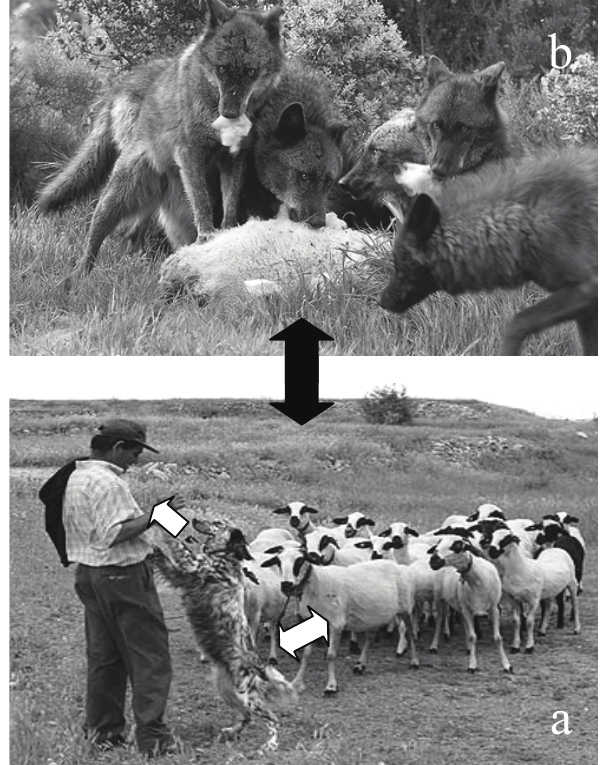
Figure 1. Epidemiology of Echinococcusgranulosus in Spain. The main domestic cycle is maintained between dogs and sheep, with man as accidental intermediate host (a; white arrows). Wild cycles could occur between wolves, wild boars, and cervids, among others (b). The sylvatic cycle could be occasionally peridomestic (black arrow), since the G1 genotype, the most frequent in sheep and human patients, has been found in isolates from wild animals.